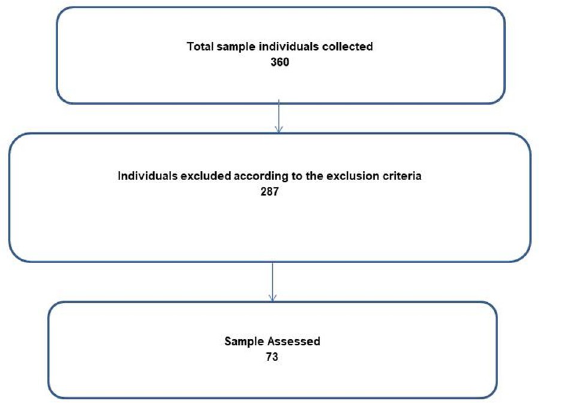
Fig 1. Assessed sample